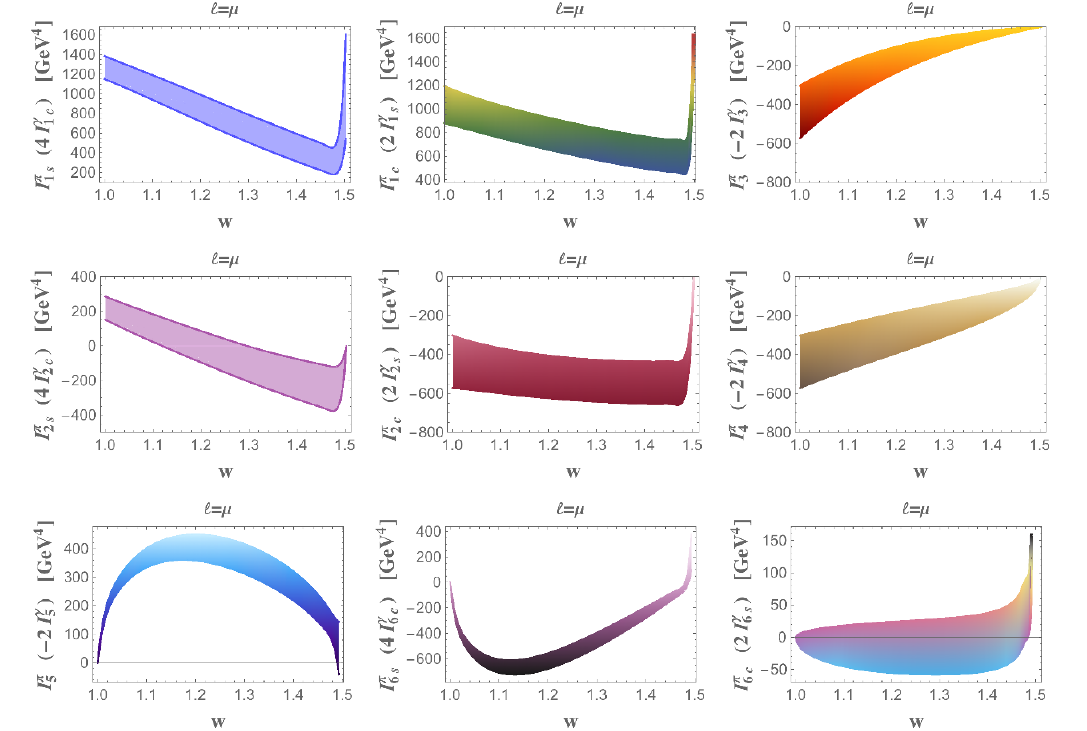
Figure 7 . Angular coe(cid:14)cients in the fully di(cid:11)erential decay distribution eq. (3.1) for ‘ = (cid:22) , with the tensor operator in the e(cid:11)ective Hamiltonian and coupling (cid:15) (cid:22) (cid:12)gure